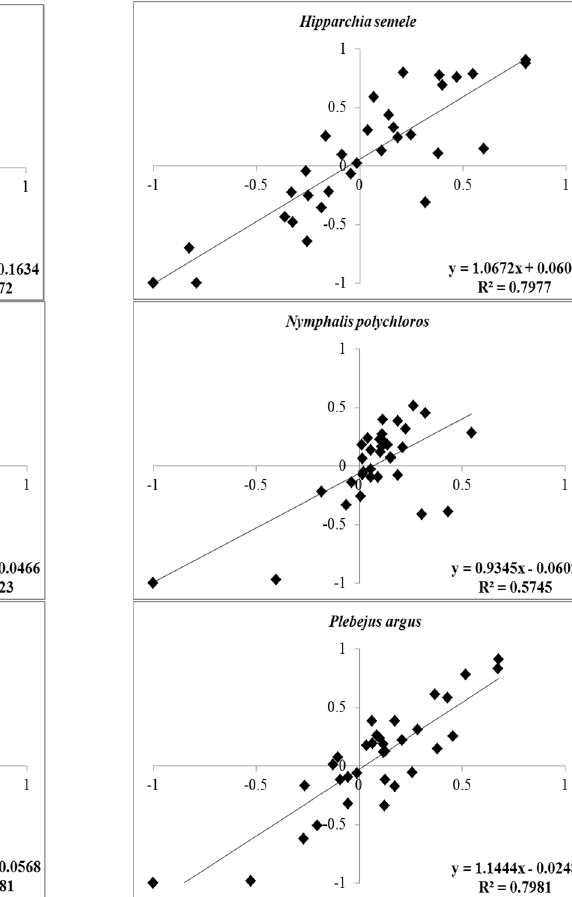
Figure 1. Relationship between IEI occup ( X ) and IEI abund ( Y ) in terms of habitat suitability of each land-cover types for the six species, based on presence data.